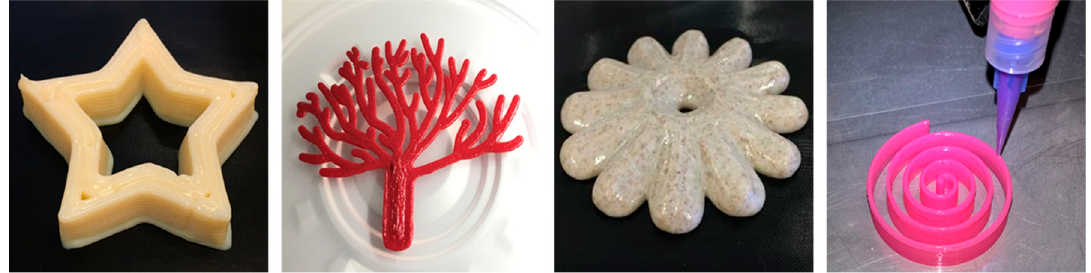
Figure 1. Example food structures made using 3D food printing (source: VTT Technical Research Centre of Finland).